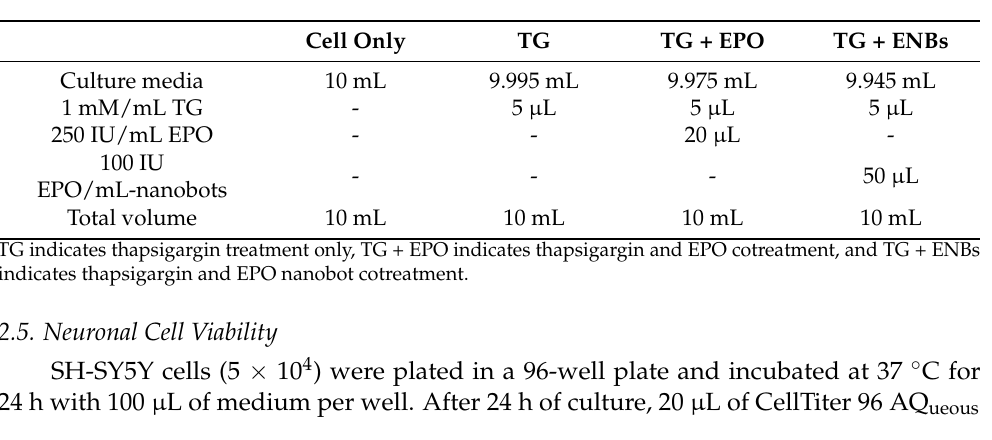
Table 1. SH-SY5Y neuronal cell